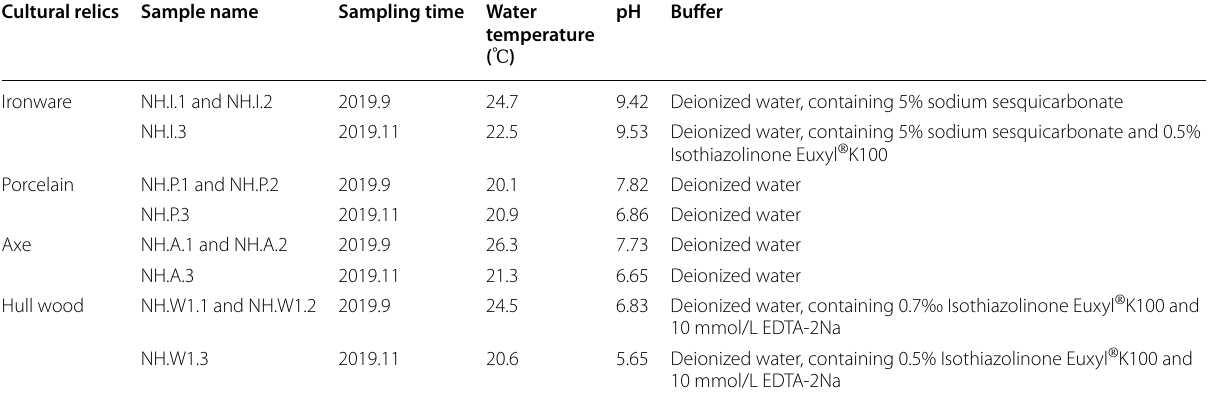
Table 1 Sampling information of four kinds of maritime cultural relic immersion water